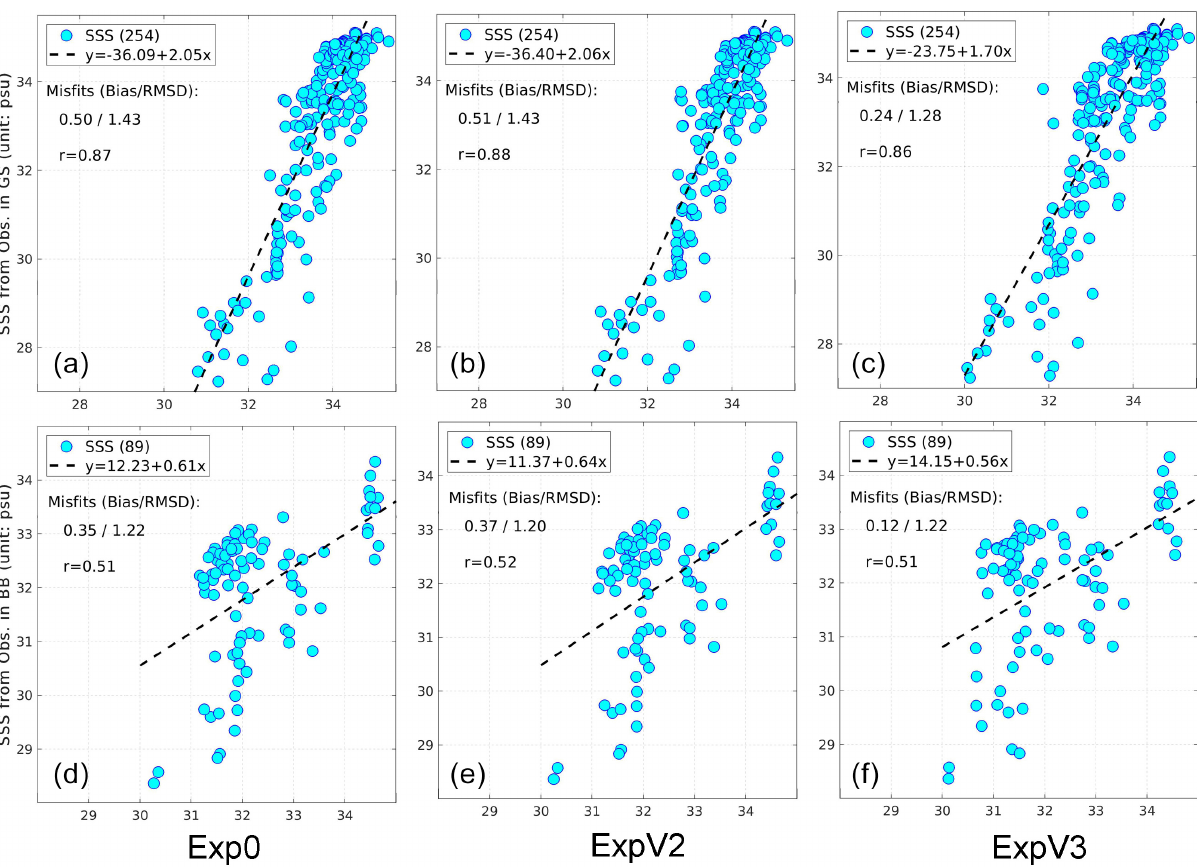
Figure 8. Scatterplots of SSS (unit: psu) in the three assimilation runs Exp0, ExpV2, and ExpV3 against CTD observations from OMG and ICES in 2016. (a–c) East Greenland Sea; (d–f) Baffin Bay, as shown in Fig. 1. The statistics of SSS misfits are indicated in each panel with the bias and the RMSD, respectively, and the number of observations is given between parentheses. The dashed dark line represents the linear regression, and r is the linear correlation coefficient. All the correlation coefficients are over the 95% significance